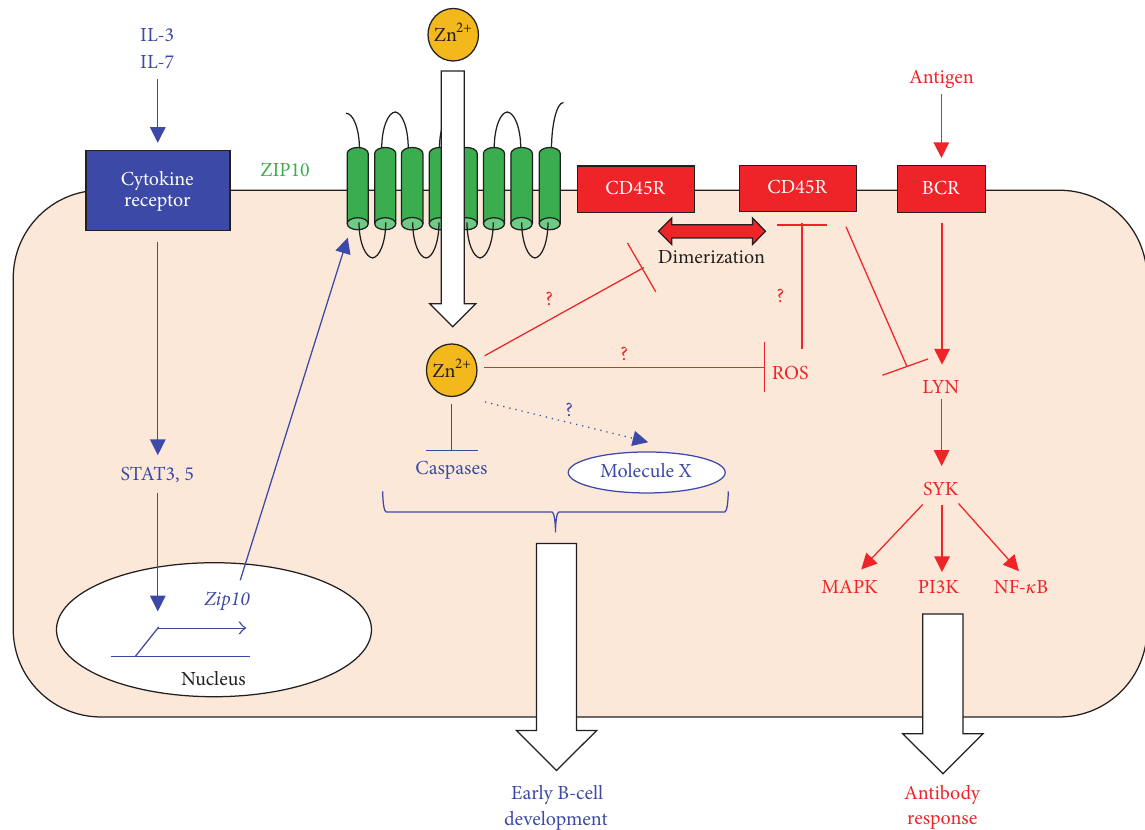
Figure 6: ZIP10’s roles in B-cell development and function. In early B-cell development, a cytokine (1st signal) induces JAK-STAT activation (2nd signal), which is converted to an intracellular Zn signal (3rd signal) by ZIP10 upregulation. This system for converting intracellular signals promotes early B-cell survival by inhibiting caspase activation and/or by an unknown mechanism via molecule X (blue). In mature B cells, ZIP10-Zn signaling sets the threshold for the BCR signaling strength by regulating the CD45R PTPase activity (red). Thus, ZIP10 controls antibody-mediated immune